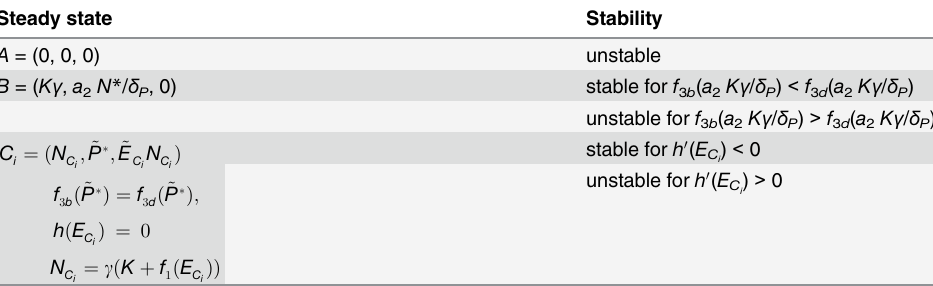
Table 2. Steady states of the macroscopic systems (13) –